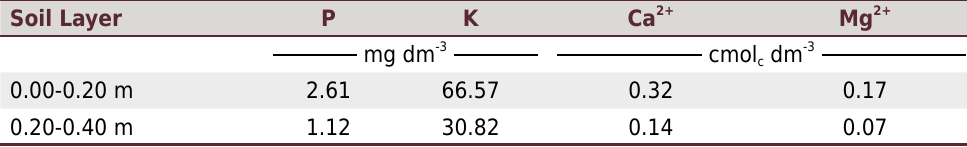
Table 8. Conversion of mean nutrient content in the biomass of 8-year-old Pinus taeda trees in soil nutrient contents in two soil layers Soil